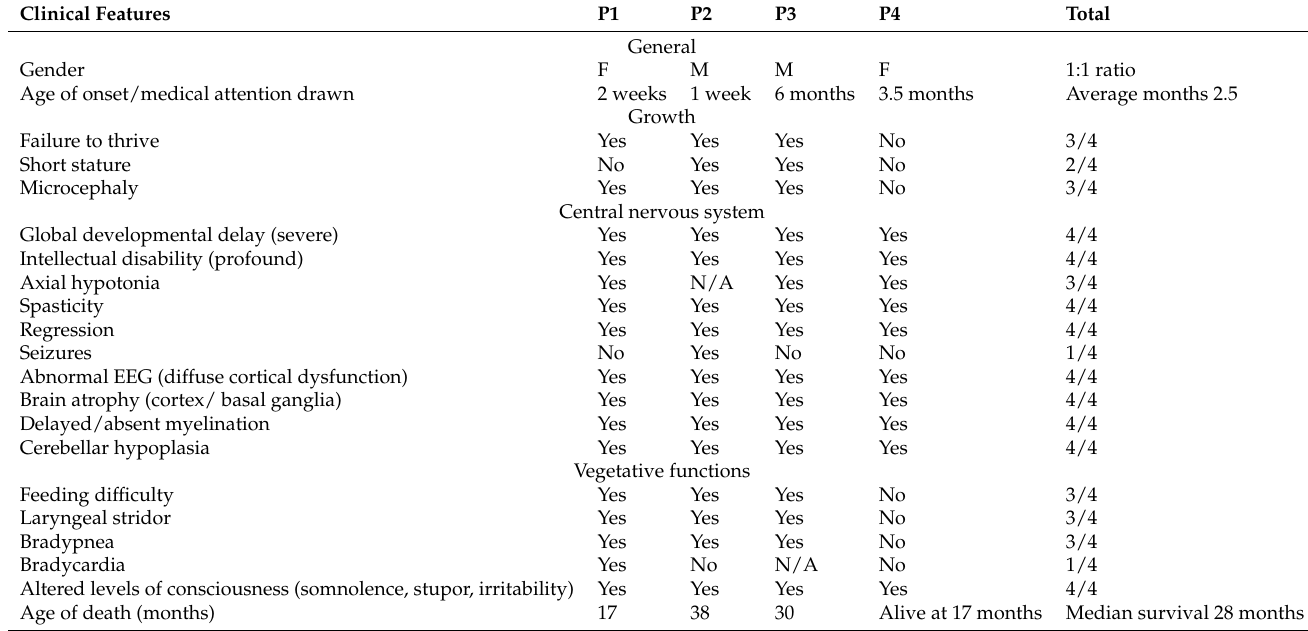
Table 2. Clinical characteristics of patients homozygous for the UFM1 c.-155_-153delTCA mutation. The table is based on and expands the work of Nahorski et al., 2018 [5]. N/A—not assessed. Clinical